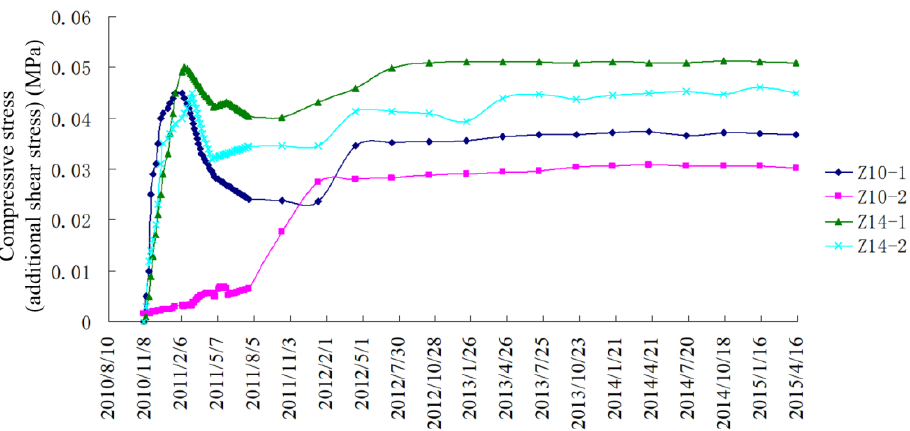
Figure 19. The stress–time curve of each measuring point of fault F4 monitored by the borehole stress meter.